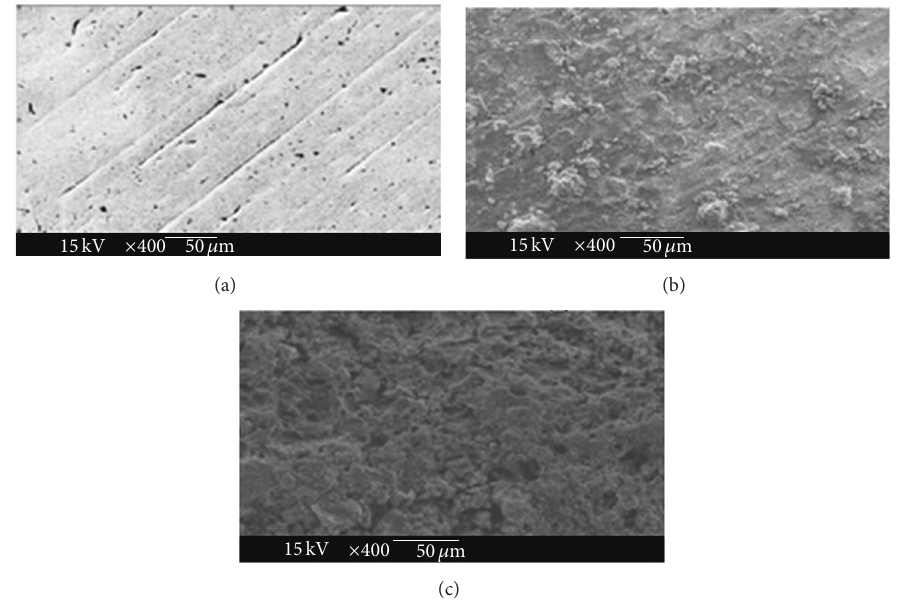
Figure 3: SEM images of MS specimen: (a) polished specimen before immersion, (b) specimen in 1M NaOH solution with inhibitor after immersion, and (c) specimen in 1M NaOH solution without inhibitor after immersion.